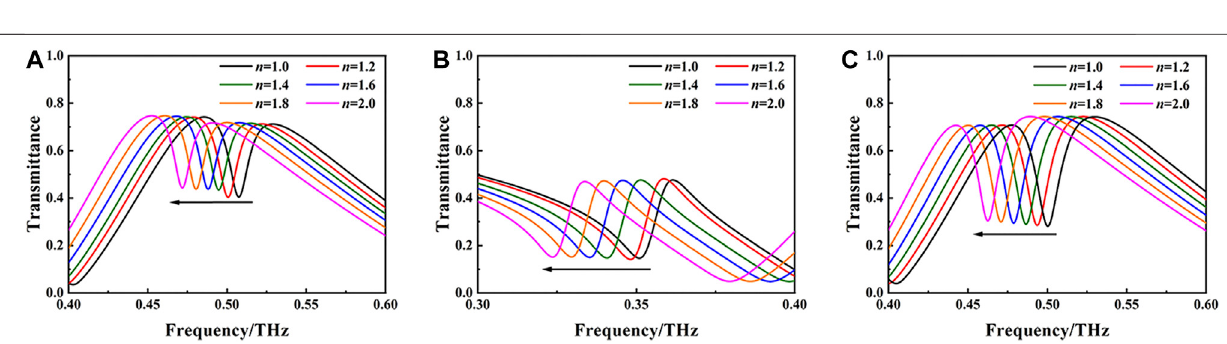
FIGURE 4 | Q factor (black spheres) and FoM (red spheres) vs. asymmetric parameter for (A) FD 1 in MM-2, (B) FD 2 in MM-3, and (C) FD3 in MM-3.